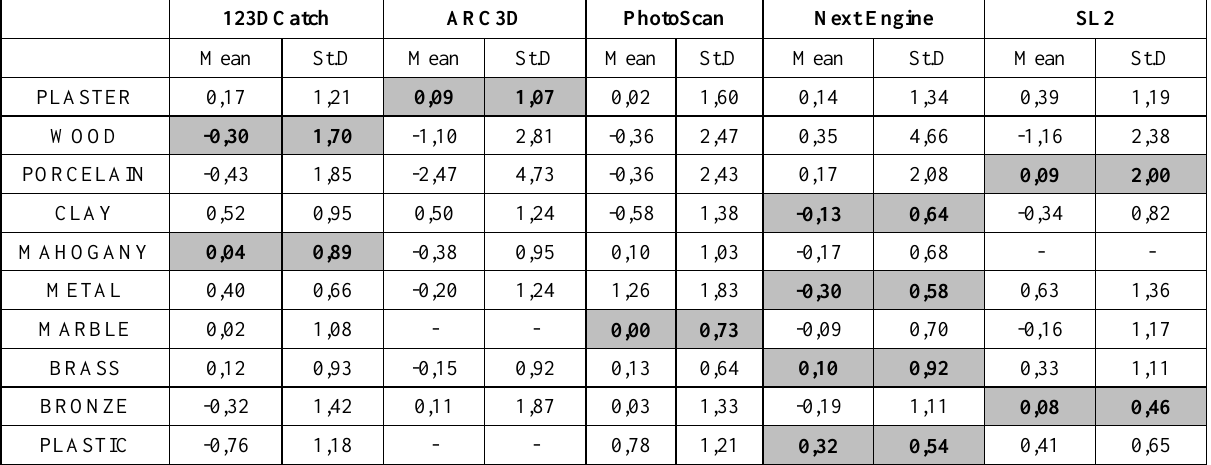
Table 1: 3D Models’ Mean Error and Standard Deviation (in mm)